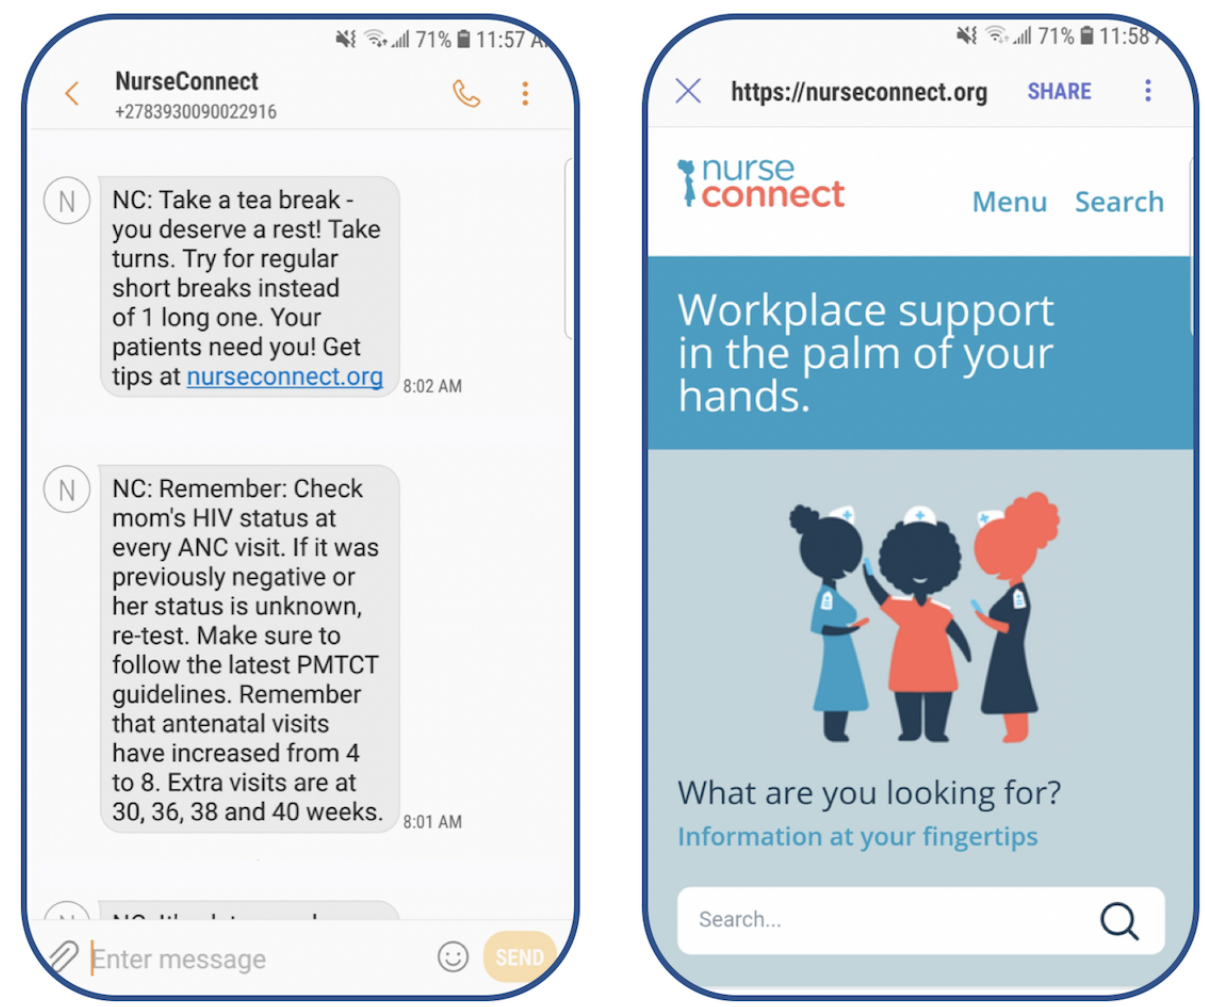
Figure 1. NurseConnect sample messages and